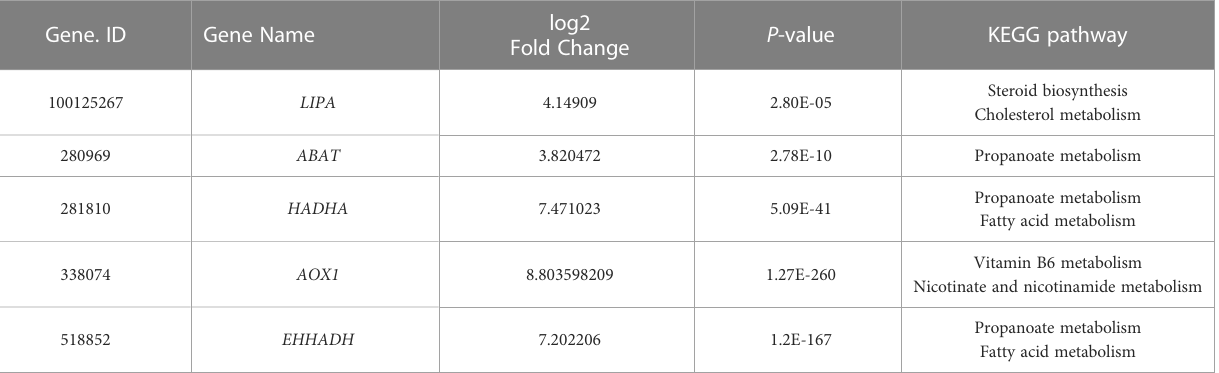
TABLE 6 Information of up-regulated expresse differentially genes.